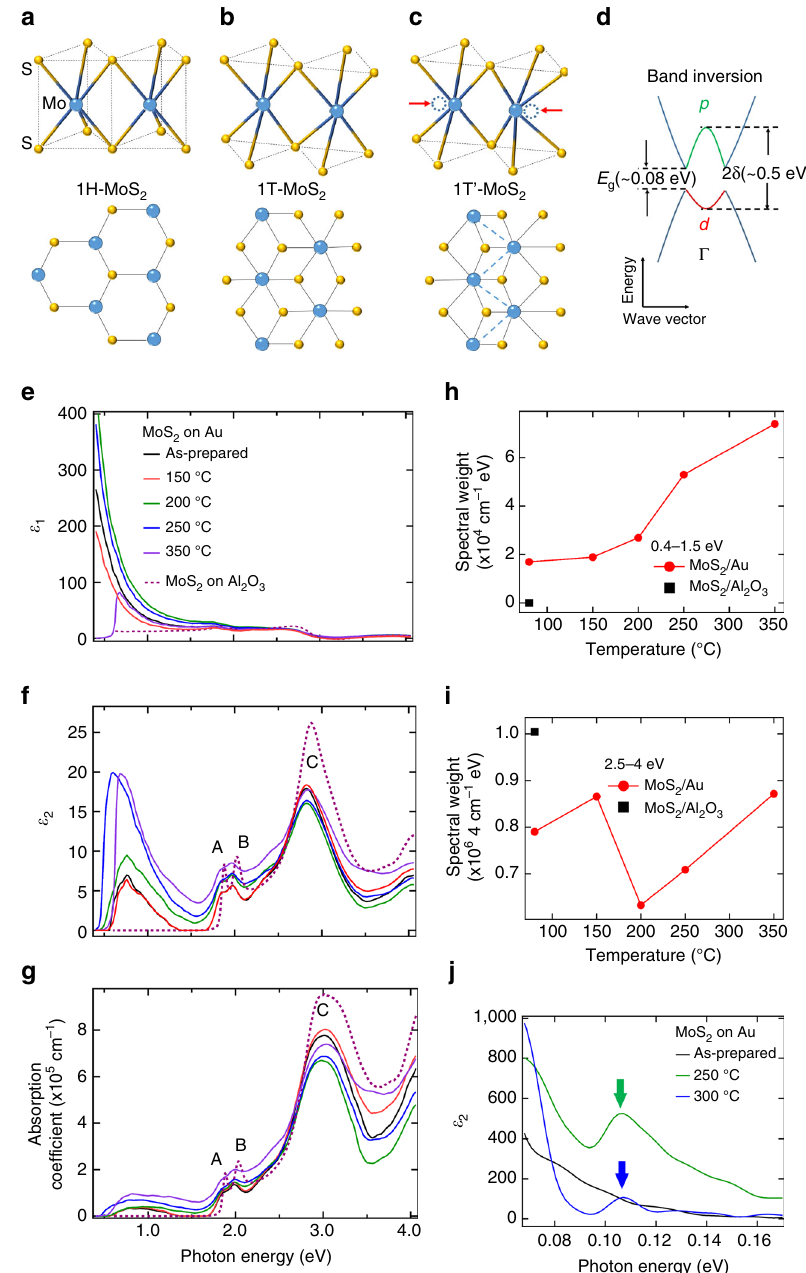
Fig. 1 Atomistic and band structures of monolayer MoS 2 and annealing temperature dependence of optical spectra. a – c Structure of 1H-MoS 2 , 1T-MoS 2 and 1T ’ -MoS 2 . d Schematic band structure of 1T ’ -MoS 2 . E g -fundamental gap; 2 δ -inverted gap. e , f Dielectric functions ε 1 and ε 2 of monolayer MoS 2 on Au annealed at various temperatures and on Al 2 O 3 substrate from VASE spectroscopic ellipsometry. g Absorption coef fi cient spectra. The color-coded vertical arrows show the shift of the threshold energy of the pre-peak from pristine (0.58 eV, black ), 250 °C (0.46 eV, blue ) to 350 °C (0.54 eV, purple ). R ω 2 α ω ; T ð Þ d ω in regions 0.4 – 1.5 and 2.5 – 4 eV. j The imaginary component of dielectric function, ε h , i Integrated spectral- weight 1 ω 1 MoS 2 /Au in the far-infrared regime from IR-VASE spectroscopic ellipsometry at various annealing temperatures with color-coded arrows indicating